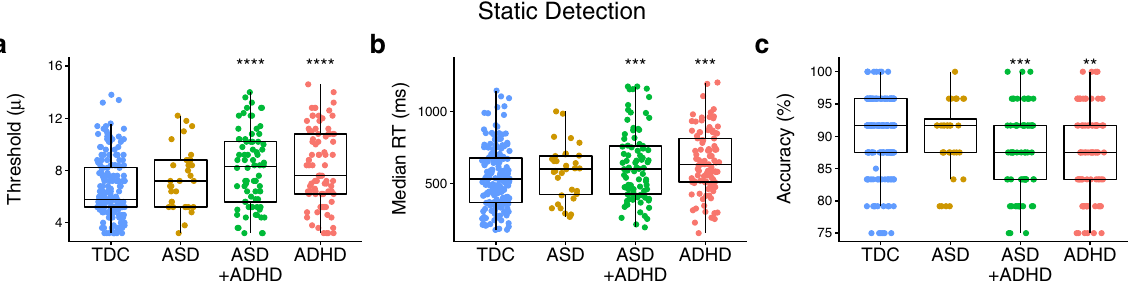
Fig. 2 Group comparisons made on performance outcomes from the static detection protocol. Individual data points with overlaid boxplots visualizing the group comparisons on key performance outcomes on the detection protocol, including a static detection threshold, b reaction time, and c accuracy. From these plots, it is clear that when compared to the typically developing control and ASD groups, static detection thresholds are signi fi cantly elevated in the ASD + ADHD and ADHD groups. Note that all statistical analyses presented in the main text of the manuscript for the plots presented in this fi gure are age-corrected. Values in the plots presented within this fi gure are not corrected for age due to the loss of interpretability of the units of measurement (which occurs when presenting residual rather than raw values). The precise number of participants in each group and further descriptive statistics can be found in Supplementary Methods, Supplementary Table 1. * p < 0.05, ** p < 0.01, *** p < 0.001, TDC typically developing controls, ASD autism